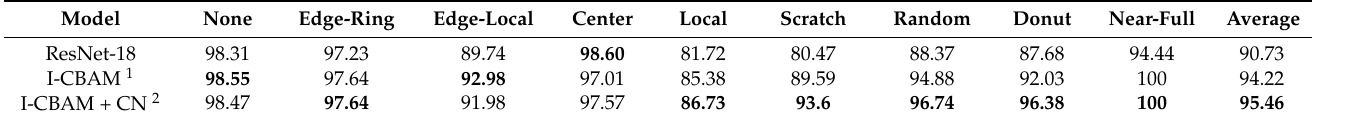
Table 3. Classification accuracies before and after classifier fine-tuning